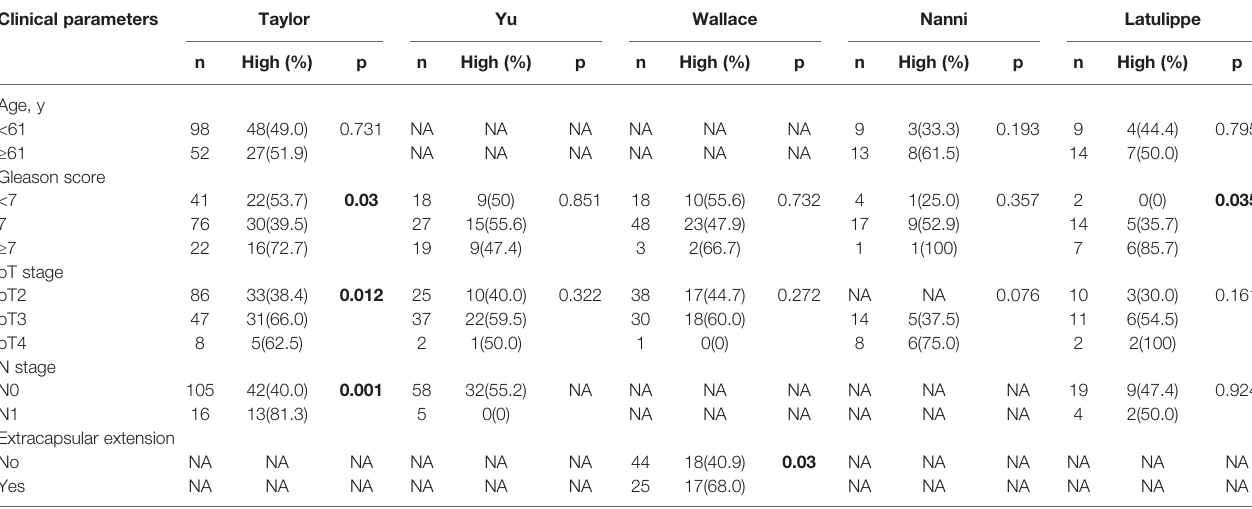
TABLE 3 | Correlation of TBX1 microarray expression pro fi les with clinicopathologic parameters in different datasets from the oncomine database. Clinical